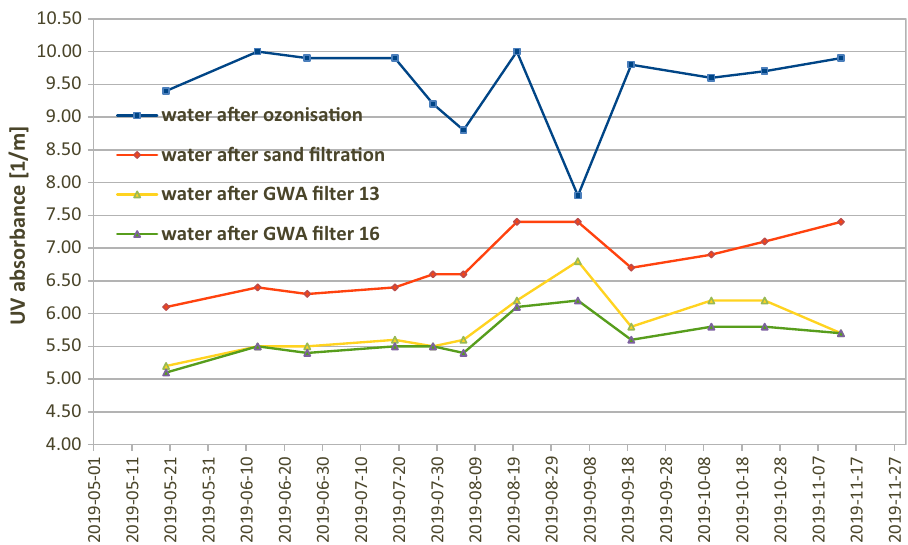
Fig. 6 UV absorbance at 254 nm of the tested samples in water before ozonation, after ozonation, after carbon filter No. 13 and after carbon filter No. 16 (operating 54 months) during the study period